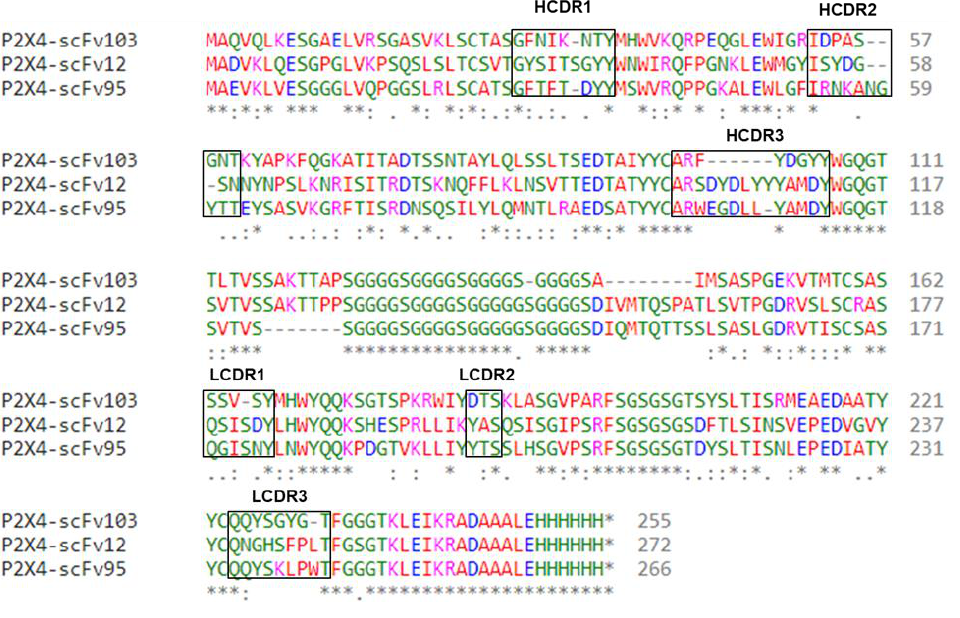
Figure 3. Amino acid sequences of V H -Linker-V L of P2X4R peptide. Amino acid sequences of V H - Linker-V L of P2X4R peptide-specific three mouse scFvs using Clustal Omega. Structural framework regions (FRs) and Complementarity-determining regions (CDRs) are determined by the IMGT information system. Diversity was found predominantly in the CDR regions. A normal 20 amino acid linker [(G4S)4] joins the V H and V L chains. Alignments were color coded according to residue property groups. AVFPMILW—red, DE—blue, RK—magenta, STYHCNGQ—green, and others— grey. * indicates sequence